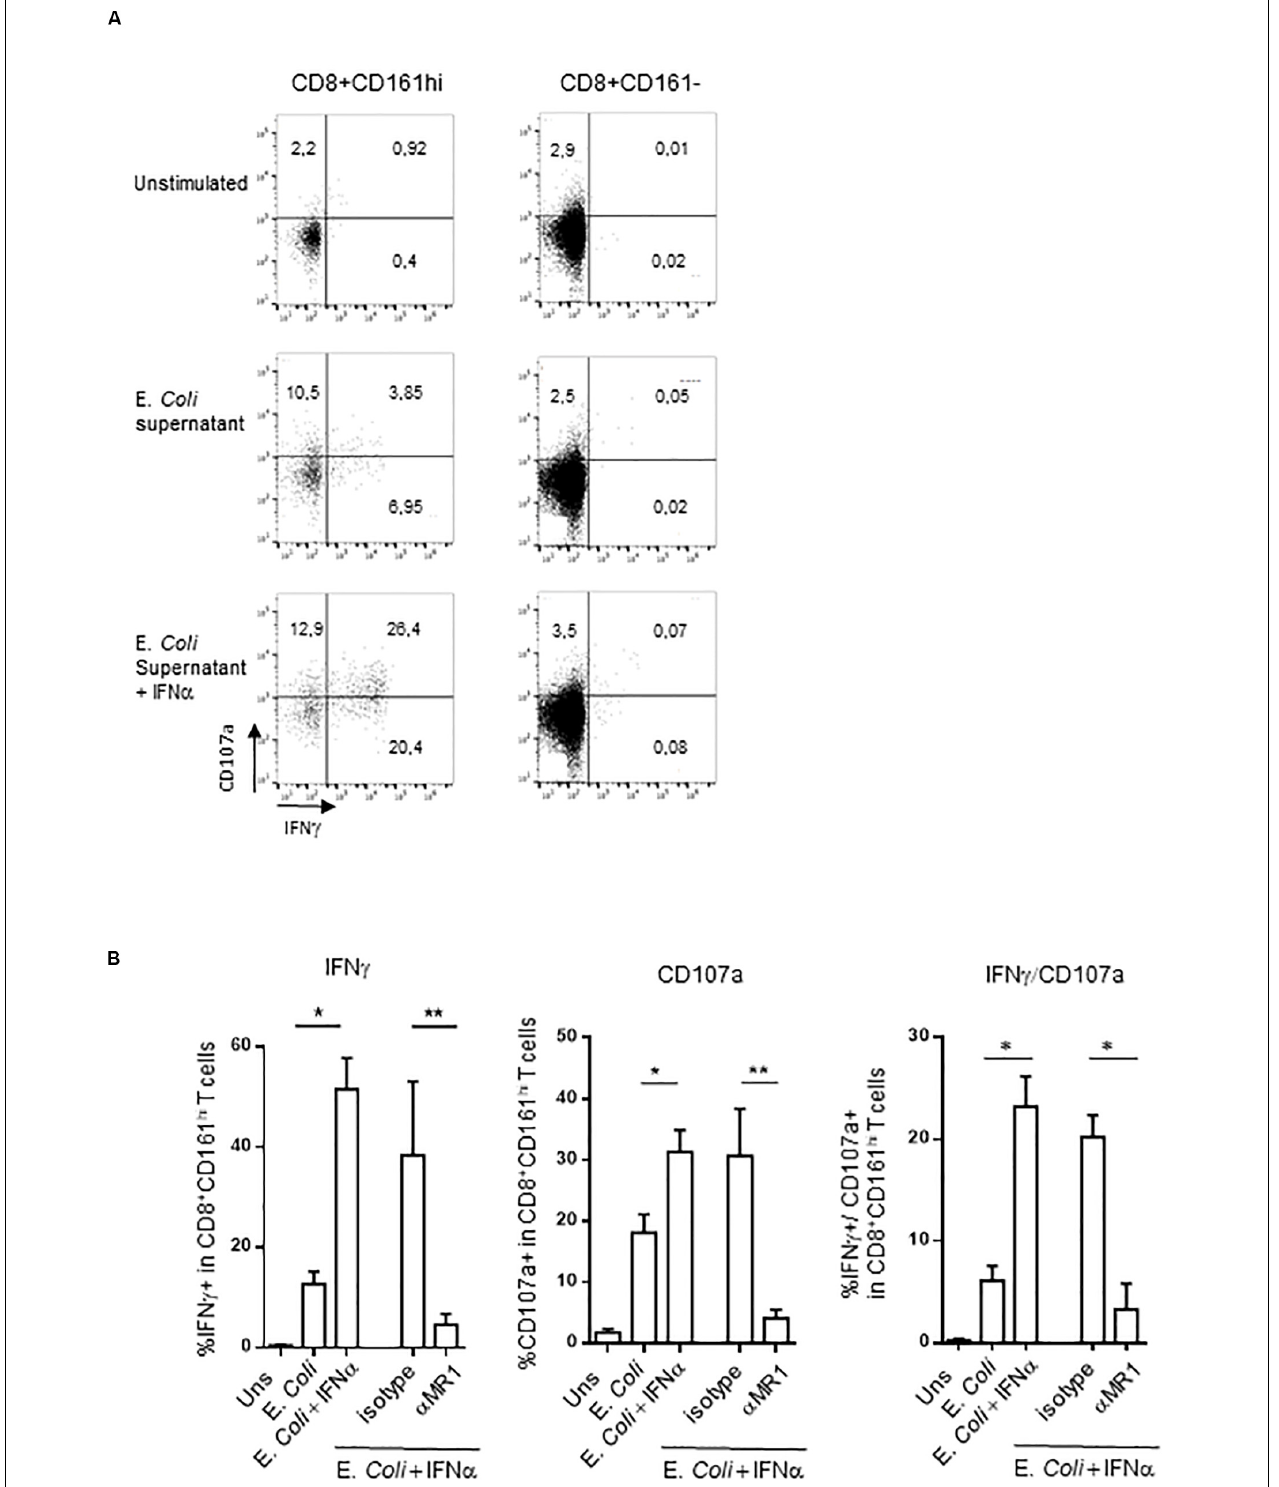
FIGURE 4 | (A) Representative flow cytometry dot plots showing membrane CD107a and intracellular IFN γ expression by CD161 hi CD8 + T cells (left) or conventional CD8 T cells (right) left unstimulated, or after stimulation with E. coli supernatant alone or in combination with IFN α 2b. (B) Cumulative frequencies (mean ± SEM) of IFN γ + (upper) and CD107a+ (lower panel) CD161 hi CD8 + T cells stimulated under the indicated conditions, N = 5. Mann–Whitney test was used to compare frequencies. ** p < 0.01, * p < 0.05; ns, not significant.